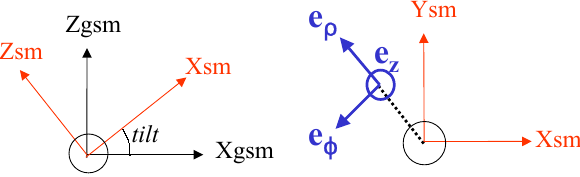
Fig. 6. Coordinate transformations from Geocentric Solar Magne- tospheric into Solar Magnetic, and from Solar Magnetic into the local cylindrical coordinate system [ e ρ , e ϕ , e z ], used in our analysis. The black circle represents the Earth, and the blue circle the Cluster spacecraft tetrahedron.